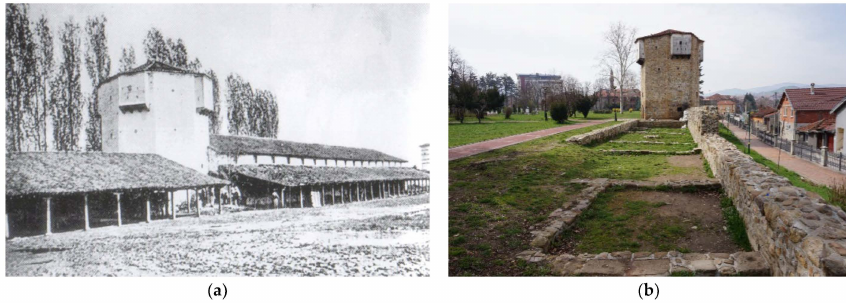
Figure 10. Tower Motrilja. ( a ) Archive photo—Tower Motrilja in 1918 (Photo source: private archive of Vladan Vidosavljevi´c). ( b ) Present state of the tower with the remains of the Turkish barracks from the period of Abdul Aziz’s reign (Photo source: private archive of Vladan